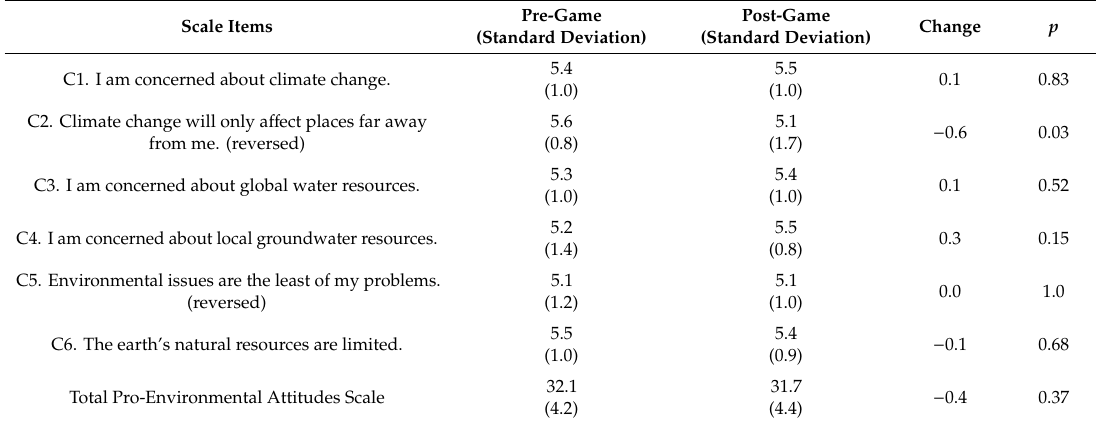
Table 4. Pro-environmental Attitudes. n = 41.